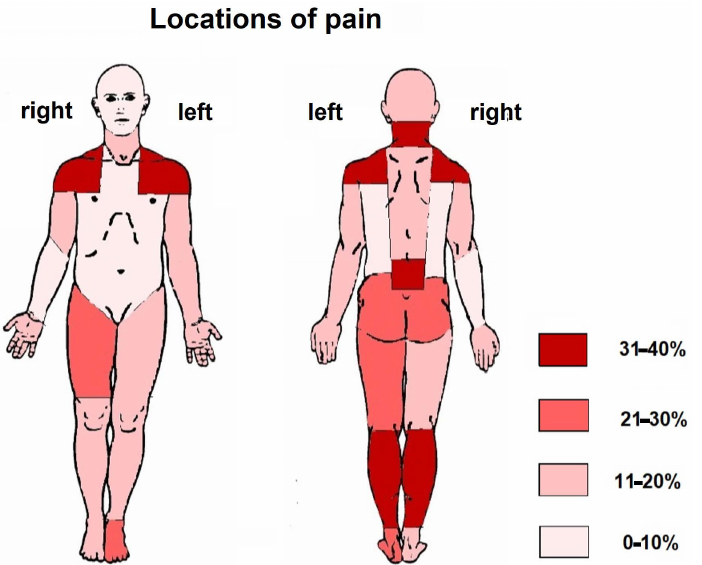
Figure 2. Representation of pain locations on front and back body diagrams indicating percentage frequency distributions for the patients with